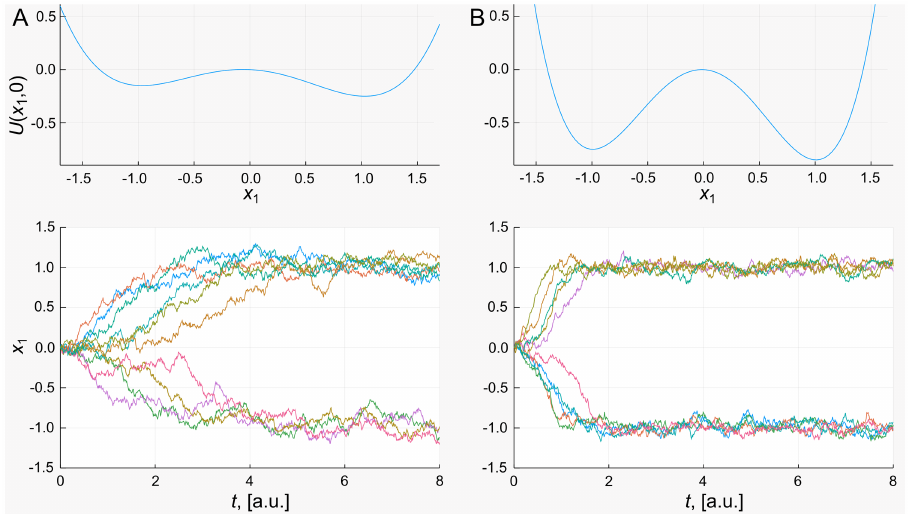
Fig 2. Influence of eigenvalues. Slice through the potential and example trajectories away from the transition state under different model parameters: (A) small positive eigenvalue ( α = 0.4); (B) large positive eigenvalue ( α = 1.6). For a larger positive eigenvalue the wells of the system are deeper and the curvature is greater, leading to more rapid movement away from the transition state.